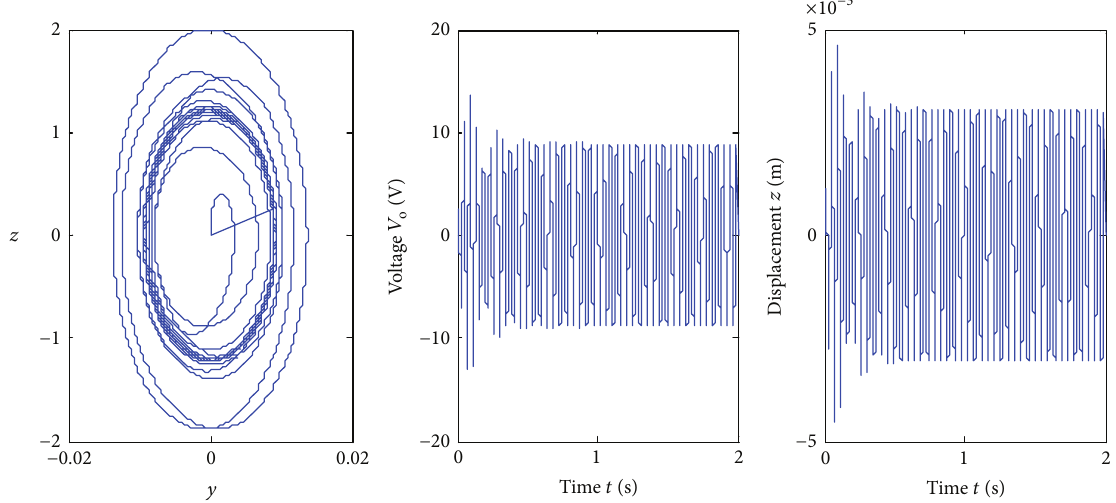
Figure 10: A periodic motion around the equilibrium position when 𝑑 = 20 mm and 𝑓 = 21